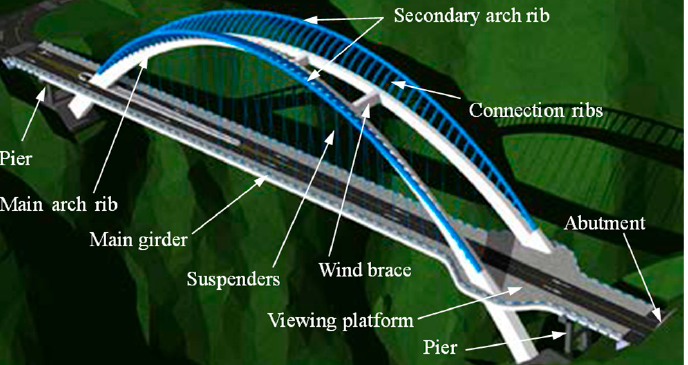
Figure 2. Main components of the main and secondary arch collaborative Y-shaped steel box arch bridge.